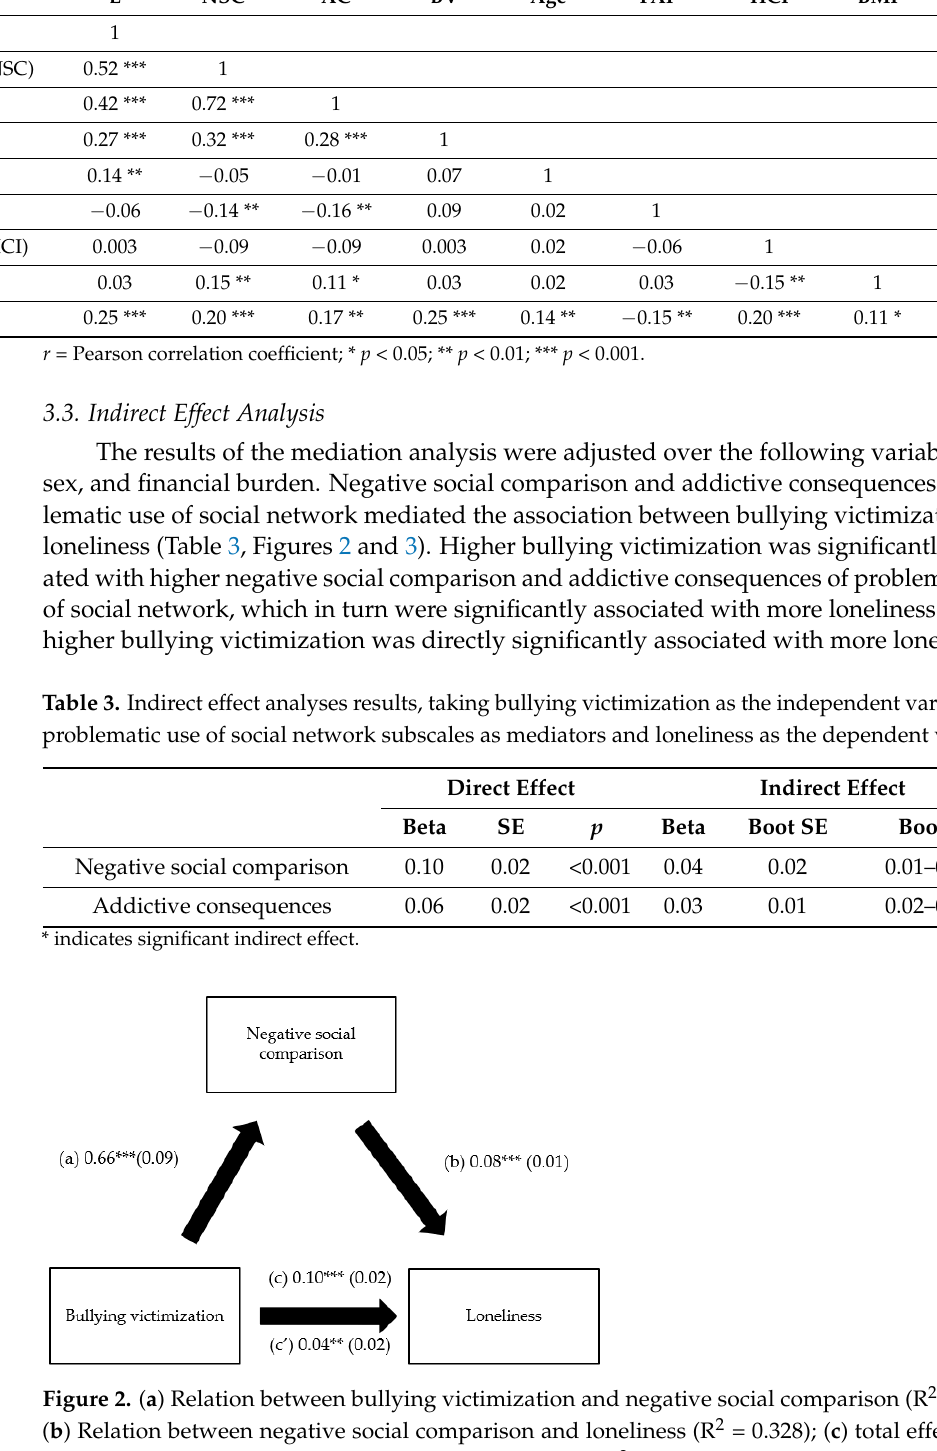
Figure 3. ( a ) Relation between bullying victimization and addictive consequences of problematic use of social network (R 2 = 0.119); ( b ) relation between addictive consequences of problematic use of social network and loneliness (R 2 = 0.254); ( c ) total e ff ect of the relation between bullying victim- ization and loneliness (R 2 = 0.153); ( c’ ) direct e ff ect of the relation between bullying victimization and loneliness. Numbers are displayed as regression coe ffi cients (standard error). *** p < 0.001. 4. Discussion To our knowledge this is the fi rst preliminary study to evaluate the association be- tween BV and loneliness among Lebanese adolescents, taking into account the indirect e ff ect of PUSN. These fi ndings may contribute to the development of loneliness preven- tion strategies for future generations.